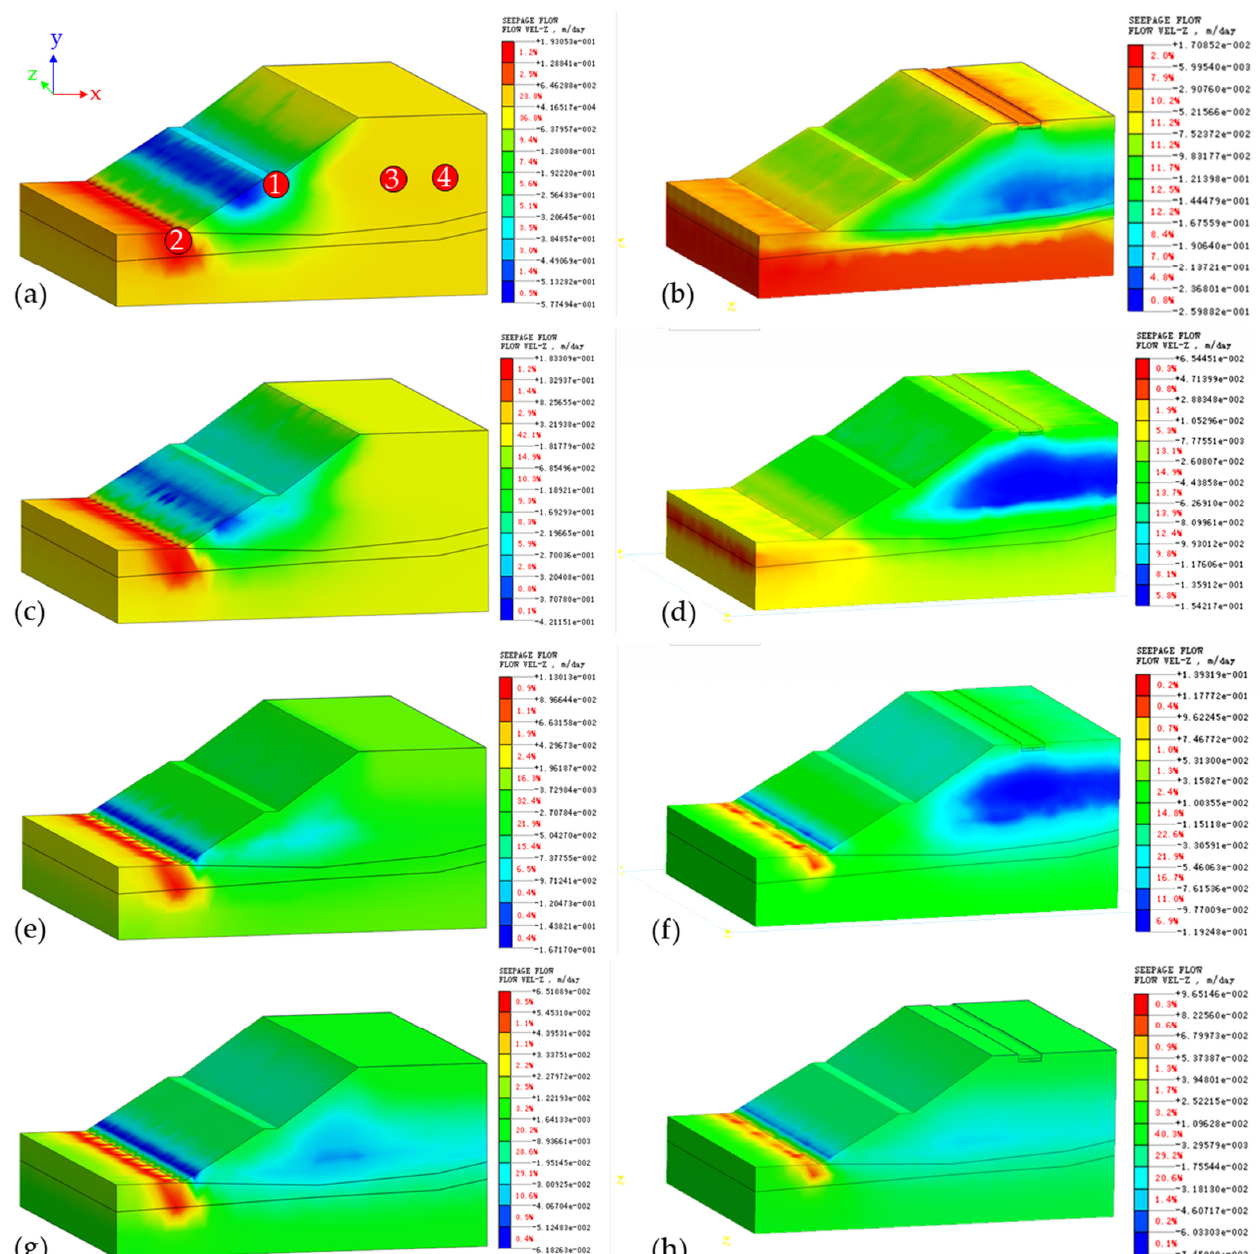
Figure 7 is the cloud diagram of the flow velocity distribution of subgrade slope within 48 h after rainfall without and with bioretention facility.